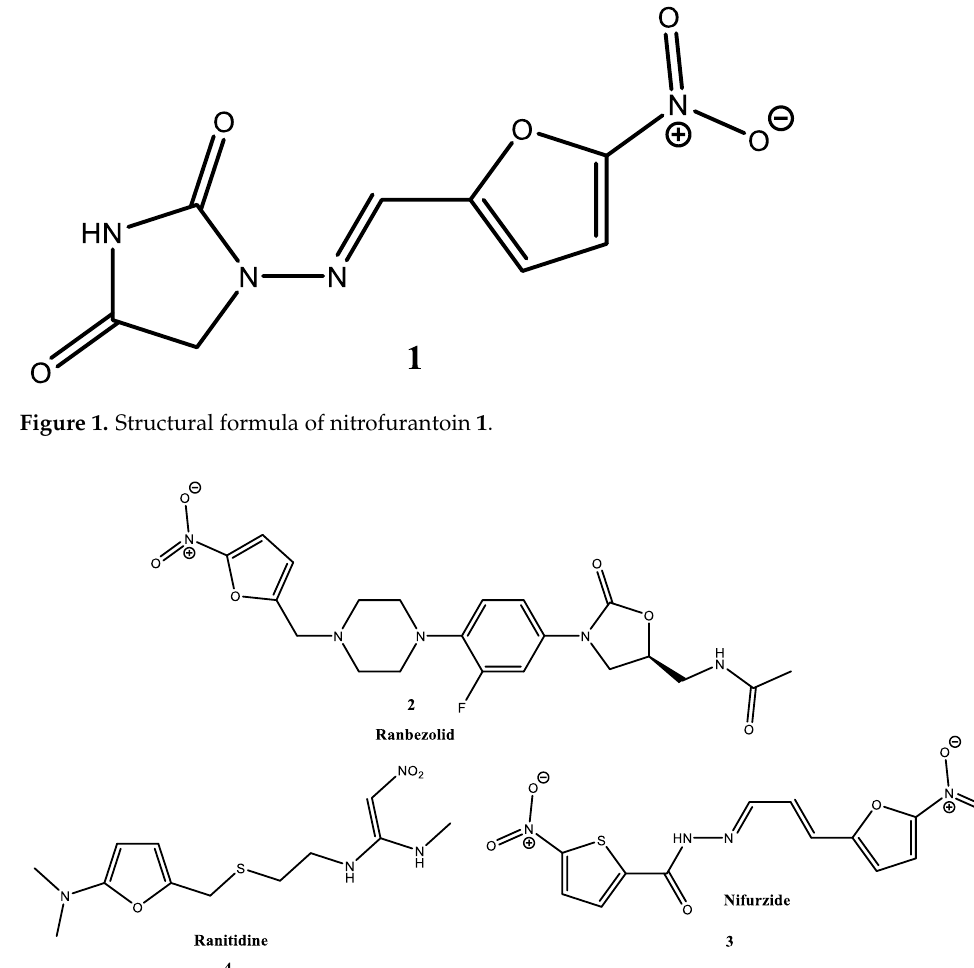
Figure 2. Structural formulas of ranbezolid, nifurzide, and ranitidine.